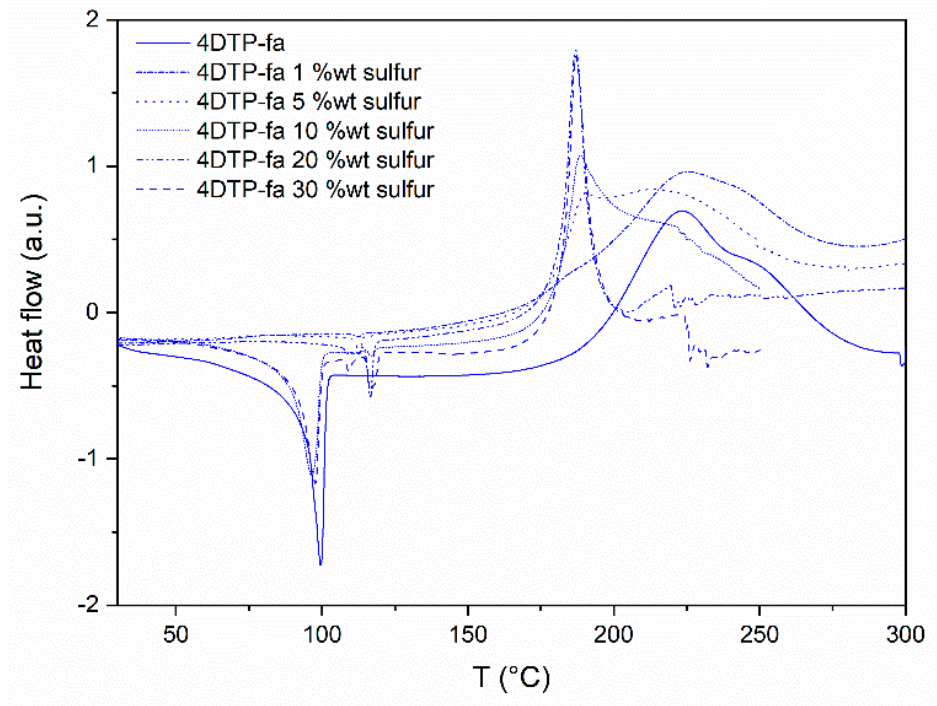
Figure A24. DSC thermogram of 4DTP-fa, 4DTP-fa with 1, 5, 10, 20 and 30 %wt of sulfur.